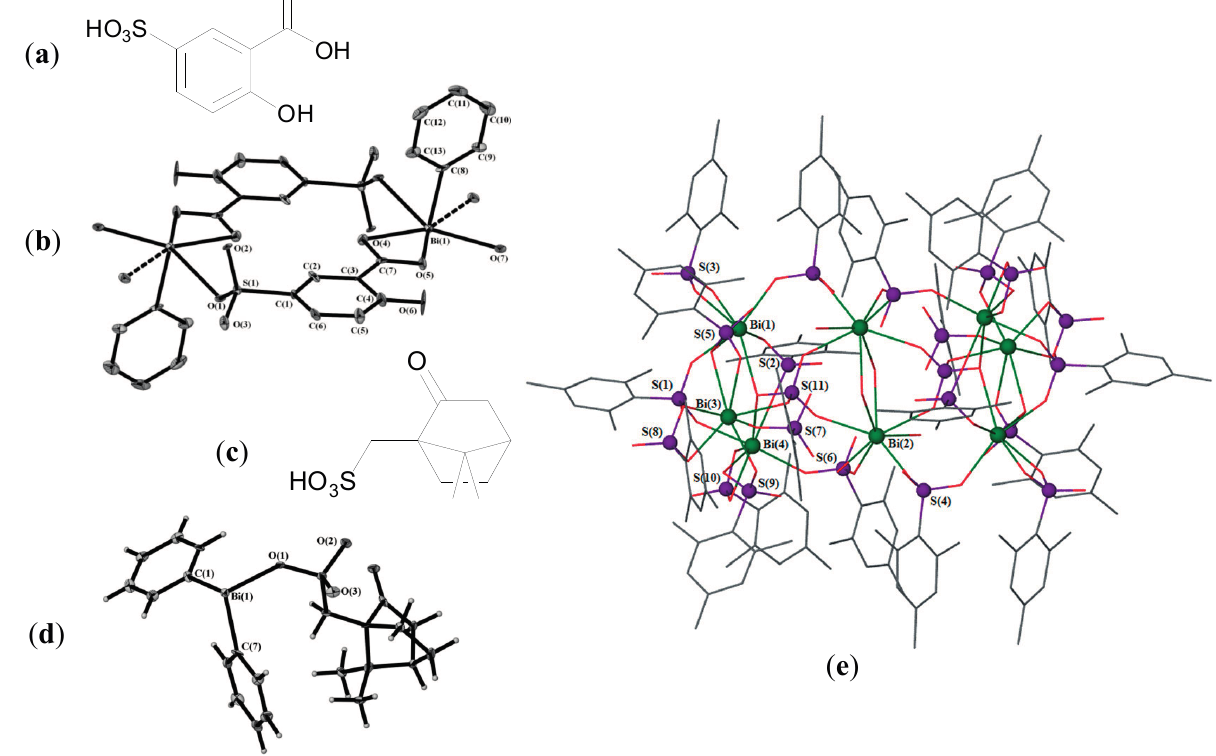
Figure 7. ( a ) Structure of 5-sulfosalicylic acid; ( b ) Structure of [PhBi(HSal)H 2 O] ∞ showing the basic dimeric unit. Reproduced from [75] with permission from The Royal Society of Chemistry; ( c ) Structure of the S -(+)-10-camphoryl sulfonic acid derivative; ( d ) Molecular structure of [Ph 2 Bi(O 3 S-Cam)] ∞ . Reproduced from [76] with permission from The Royal Society of Chemistry; ( e ) Molecular structure of [Bi toluene and H atoms omitted for clarity. Reproduced from [78] with permission from The Royal Society of